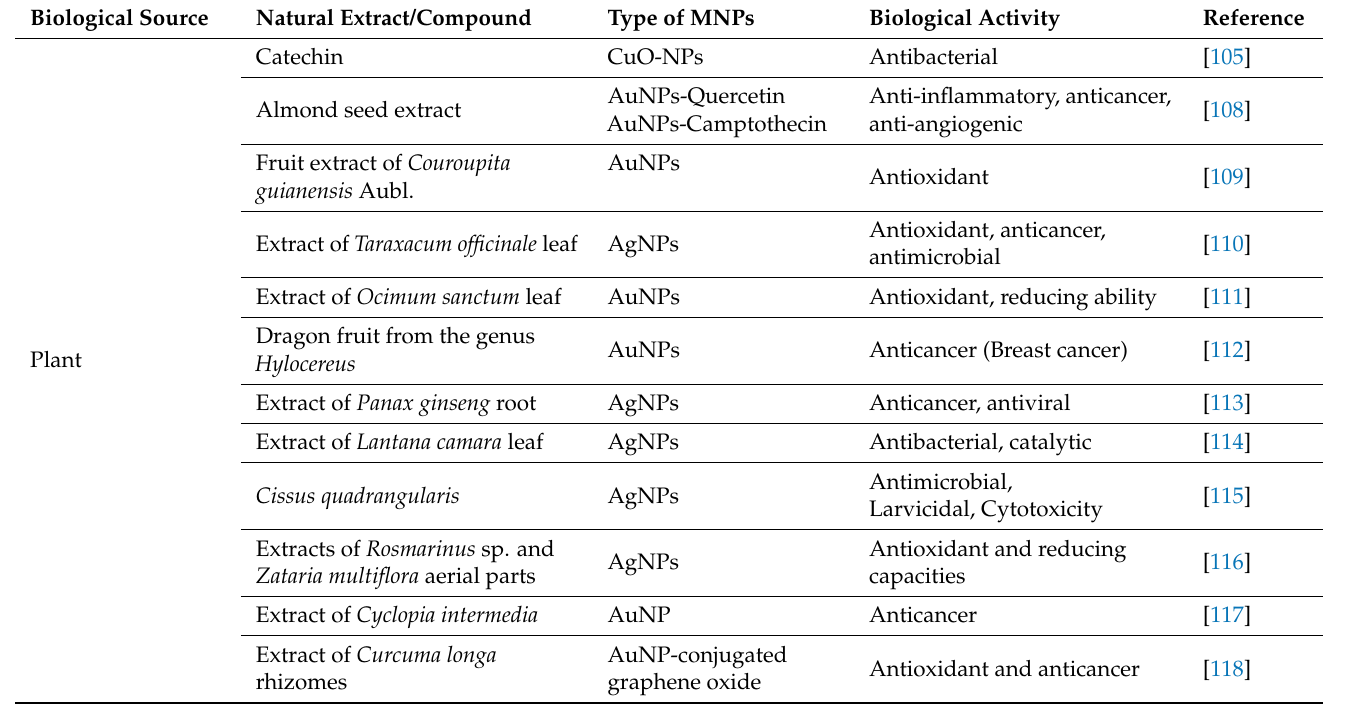
Figure 7. General schematic representation of the antibacterial mode of action for metal-based nanoparticles. The MNPs interact with the membrane of the bacteria, causing membrane disruption. This interaction also brings about the frequent generation of free radicals (ROS yellow spots) which may generate another secondary damage, hinder protein function, cause DNA destruction, and result in excess radical production. These nanomaterials can also proceed via photoactivation (photocatalyst); nitric oxide (NO) NM is involved with RNS (green spots). Redrawn from [107], with permission from Hindawi Publishing Corporation (copyright 2022). Table 3 : Some Plant mediated Metal ‐ based Nanoparticles with their Biological Potentials Biological Source